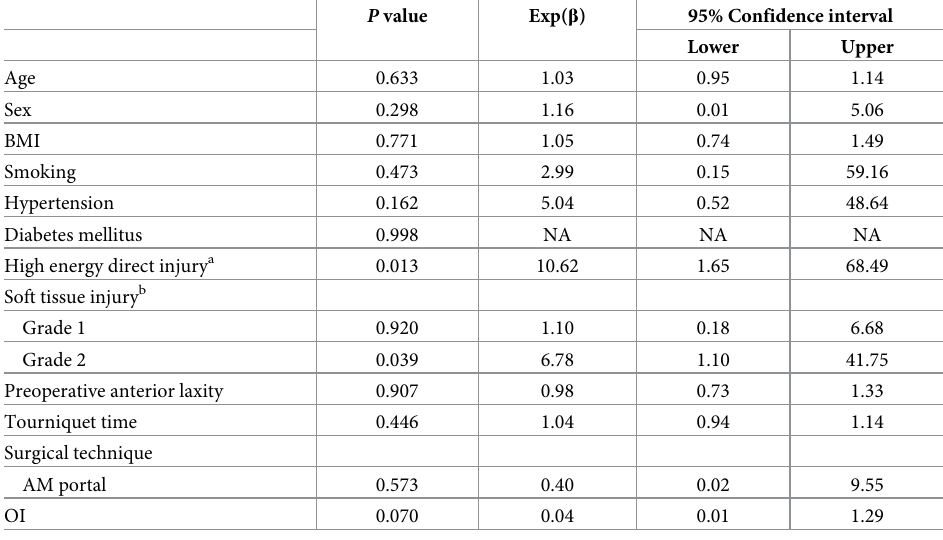
Table 2. Logistic regression analysis for proximal DVT after ACL reconstruction. P value Exp( β ) 95% Confidence interval Lower Upper Age 0.633 1.03 0.95 1.14 Sex 0.298 1.16 0.01 5.06 BMI 0.771 0.74 1.49 Smoking 0.473 2.99 0.15 59.16 Hypertension 0.162 5.04 0.52 48.64 Diabetes mellitus 0.998 NA NA NA High energy direct injury a 0.013 10.62 1.65 68.49 Soft tissue injury b Grade 1 0.920 1.10 0.18 6.68 Grade 2 41.75 Preoperative anterior laxity 0.907 0.98 0.73 1.33 Tourniquet time 0.446 1.04 0.94 1.14 Surgical technique AM portal 0.573 0.40 0.02 9.55 OI 0.070 0.04 0.01 1.29 DVT, deep vein thrombosis; ACL, anterior cruciate ligament; BMI, body mass index; AM portal, anteromedial portal; OI, outside in; NA, not applicable a High energy direct injury was analyzed on the basis of low energy indirect injury. b Grade 1 and grade 2 soft tissue injury were analyzed on the basis of grade 0 soft tissue injury.